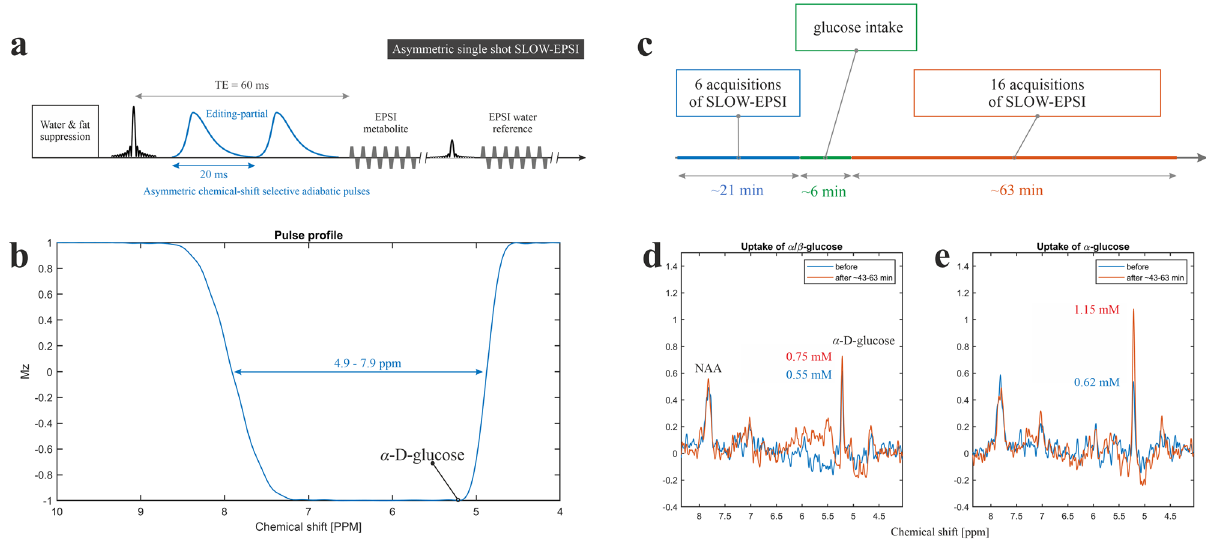
Figure 3. ( a ) Single-shot SLOW-editing EPSI-based sequence used (Scheme 2), which makes use of an asymmetric 2π-CSAP. ( b ) Pulse profiles of the asymmetric refocusing/editing CSAP. ( c ) Flowchart illustrating the in vivo MRSI measurements in subject 2. ( d ) The downfield spectra before (blue) and after (orange) uptake of α/β -equilibrium glucose. ( e ) The downfield spectra before (blue) and after (orange) uptake of α-d- glucose.